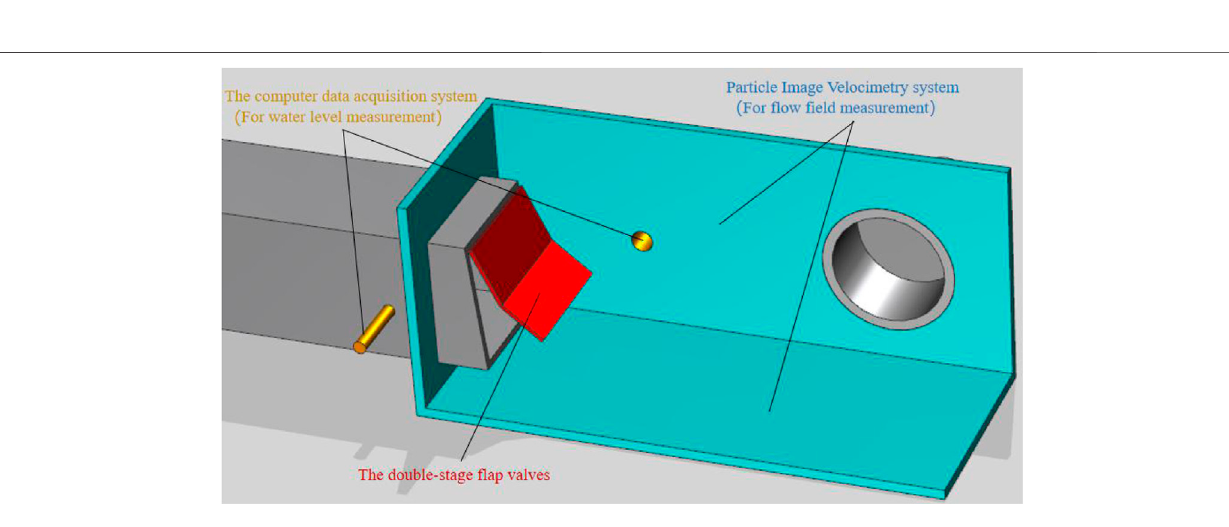
FIGURE 4 | Diagram of the model test